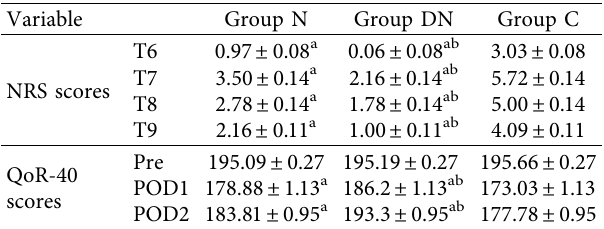
Table 3: Comparison of the NRS scores and QoR-40 scores be- tween the three groups.